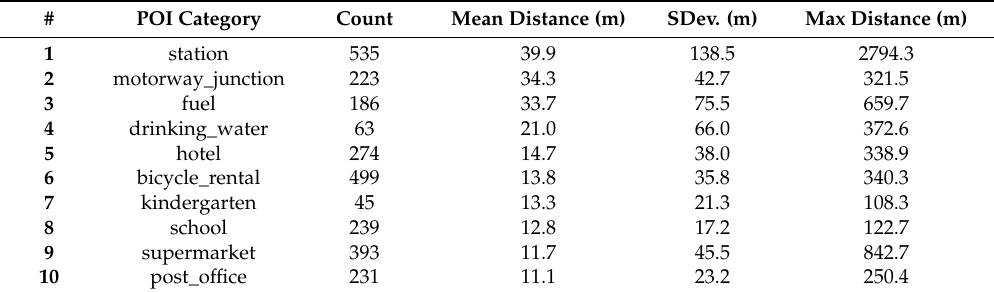
Table 2. The statistics of the positional movement of the top 10 OSM feature types according to the mean distance (in m) of positional